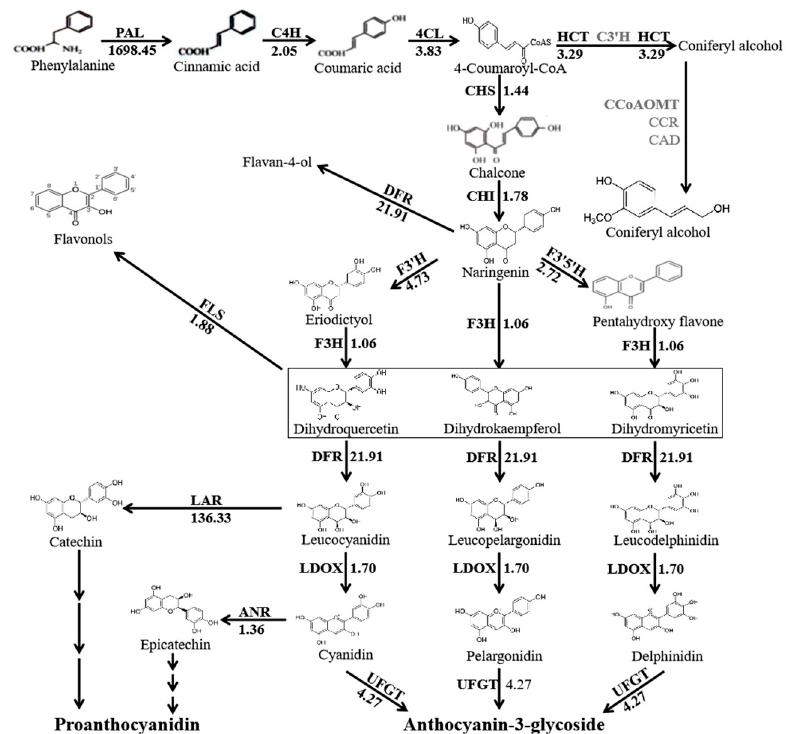
Figure 3. The expression level differences of anthocyanin biosynthesis-related structural genes in red and white coleoptiles. Arrows show the metabolic stream; the light color indicates that these genes are in the assembled UniGenes; the numbers represent the increased level of expression in red coleoptiles compared with white coleoptiles.